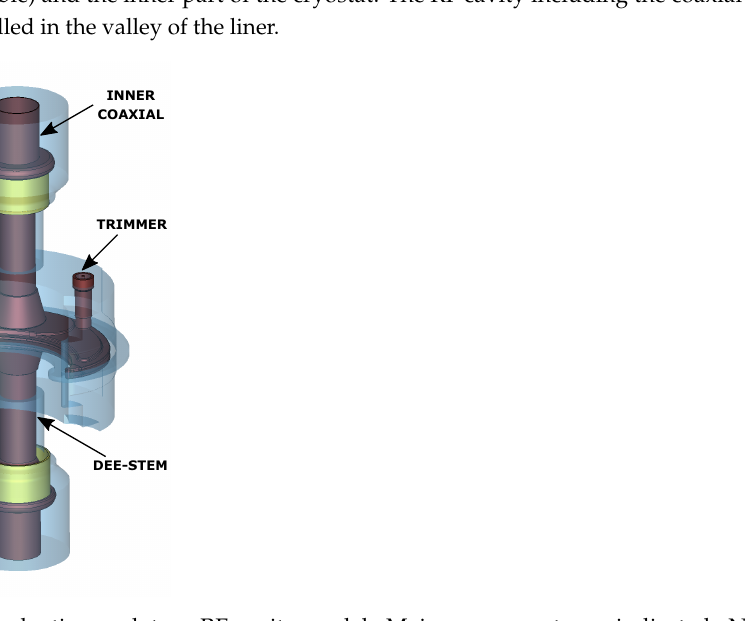
Figure 2. Superconducting cyclotron RF cavity model. Main components are indicated. NOTE: ceramic isolators between inner and outer coaxial are not visible.